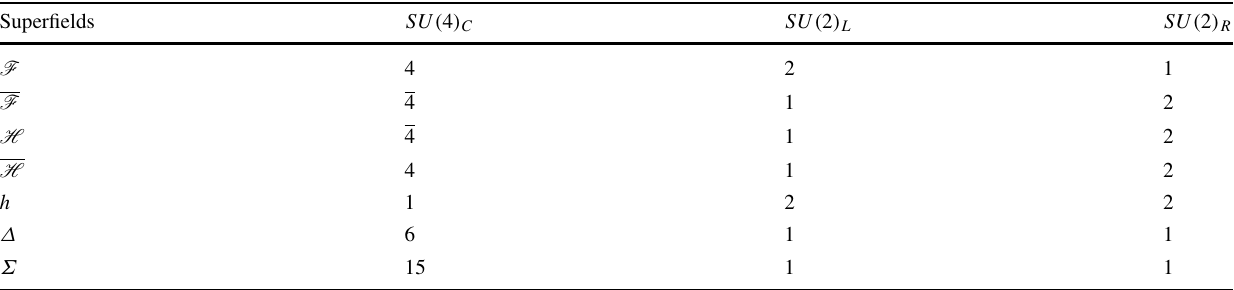
Table 53 Supersymmetric pati-salam model: quantum numbers of superfields under the gauge groups. Internal symmetry indices have been suppressed Superfields